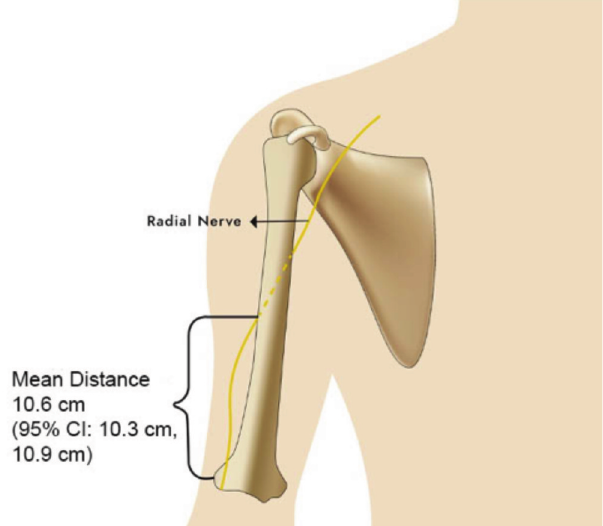
Graphic representation of the estimated mean radial nerve danger zone (RNDZ), the distance from the lateral epicondyle to the Fig. 2: lateral intermuscular septum at the spiral groove, from the studied cadavers. (CI: confidence